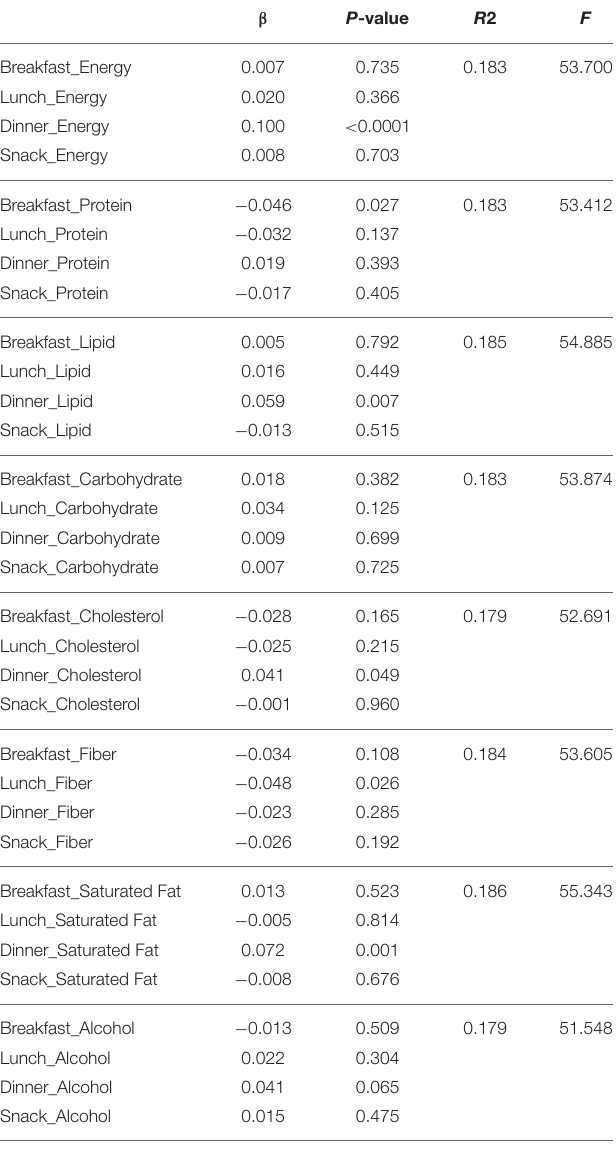
TABLE 4 | Association between the timing of nutrient intake and blood pressure including